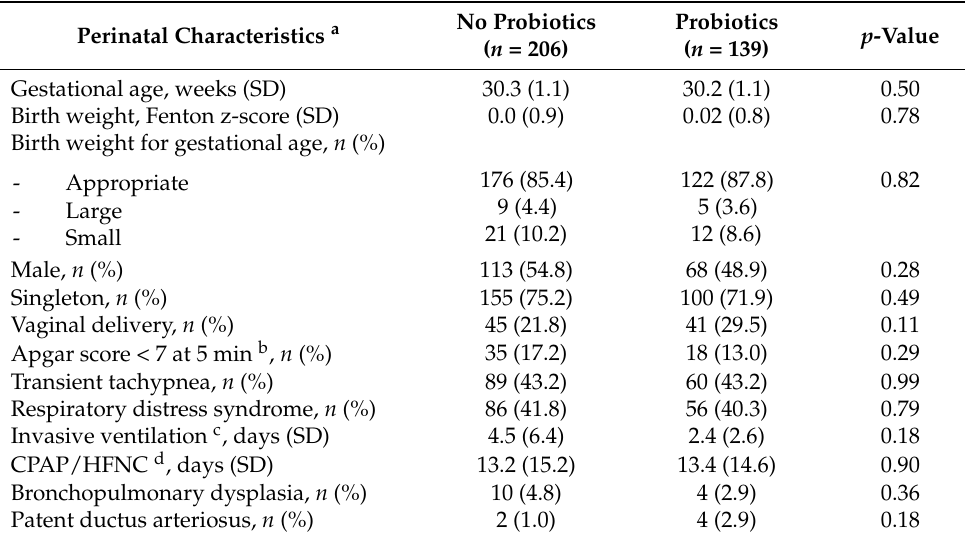
Table 1. Characteristics of 345 very preterm infants born in Stockholm before and after the implemen- tation of routine probiotics supplementation.